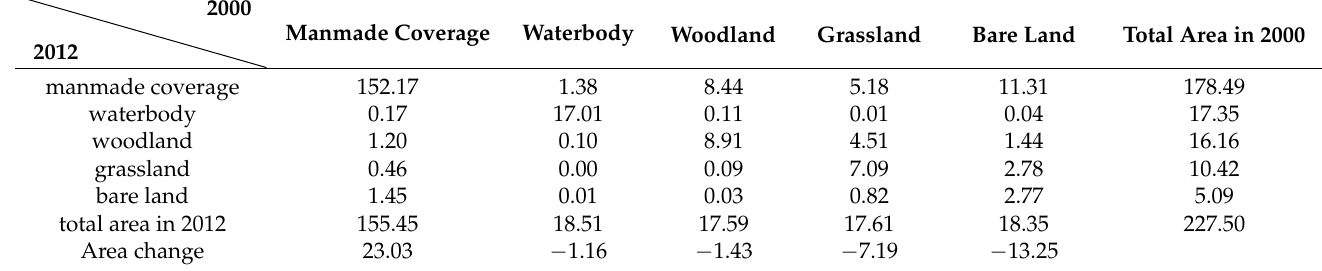
Table 4. Class-level metrics change from 2000 to 2012.